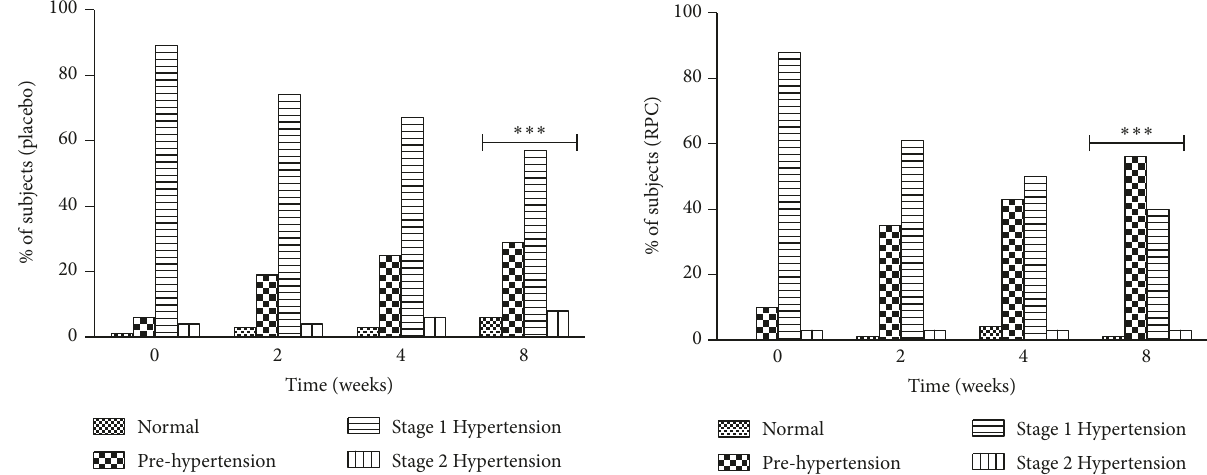
Figure 2: Proportion of ITT subjects in NIH-defined blood pressure categories at weeks 0, 2, 4, and 8 of the study based on office blood pressure. ITT: intention-to-treat; NIH: National Institutes of Health; RPC: Refined Peptide Concentrate; ∗∗∗ : p=0.006, for the difference between groups in the distribution of subjects across NIH-defined blood pressure categories, favouring RPC over